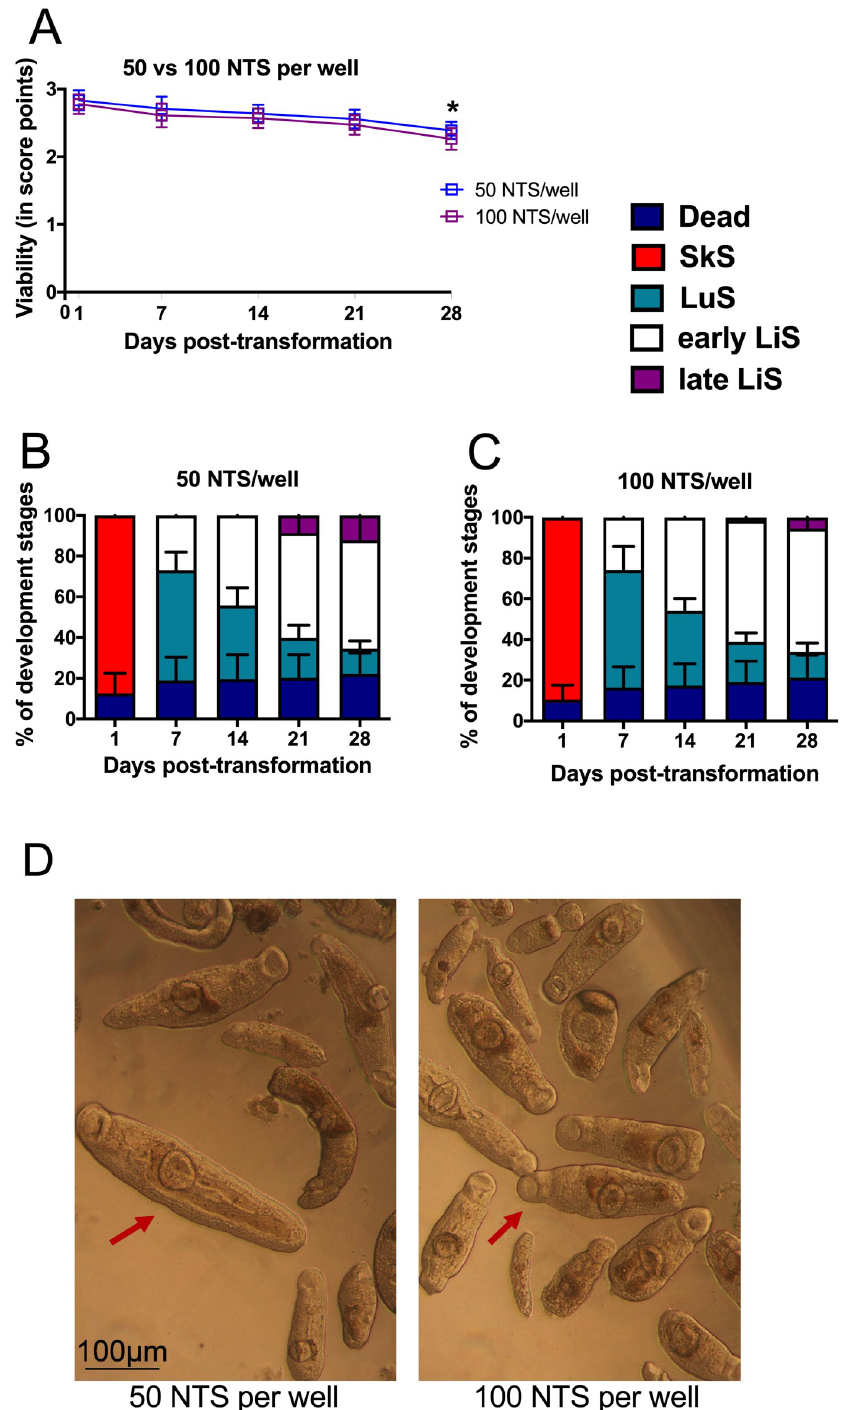
Fig 2. Downscaling the number of NTS. Approximately 50 and 100 NTS were cultured in a 96-well format with HM supplemented with 200 U/mL penicillin, 200 μ g/mL streptomycin and 20% human serum (A) Viability was scored during bright field microscopy. The percentages of the developmental stages as well as dead parasites in culture with (B) 50 NTS/well and (C) 100 NTS/well. (D) Representative photomicrographs were taken on day 28 post- transformation at 10x magnification. Arrowheads indicate the liver stage. Data represents mean ± SD for n = 18 per time point. � p � 0.05 comparing 50 NTS vs 100 NTS per well at day 28 post-transformation by Mann-Whitney non- parametric test. NTS: Newly transformed schistosomula; HM: Hybridomed Diff 1000; SkS: Skin stage; LuS: Lung stage; LiS: Liver stage.